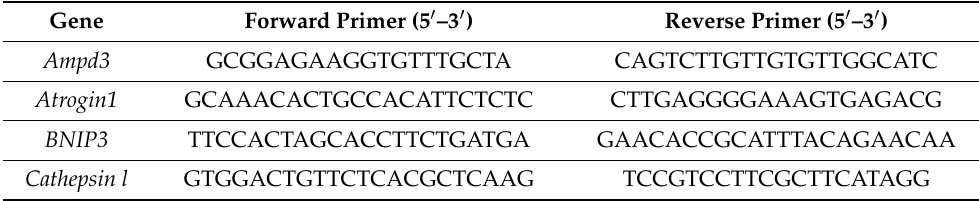
Table 1. Oligonucleotide primers.